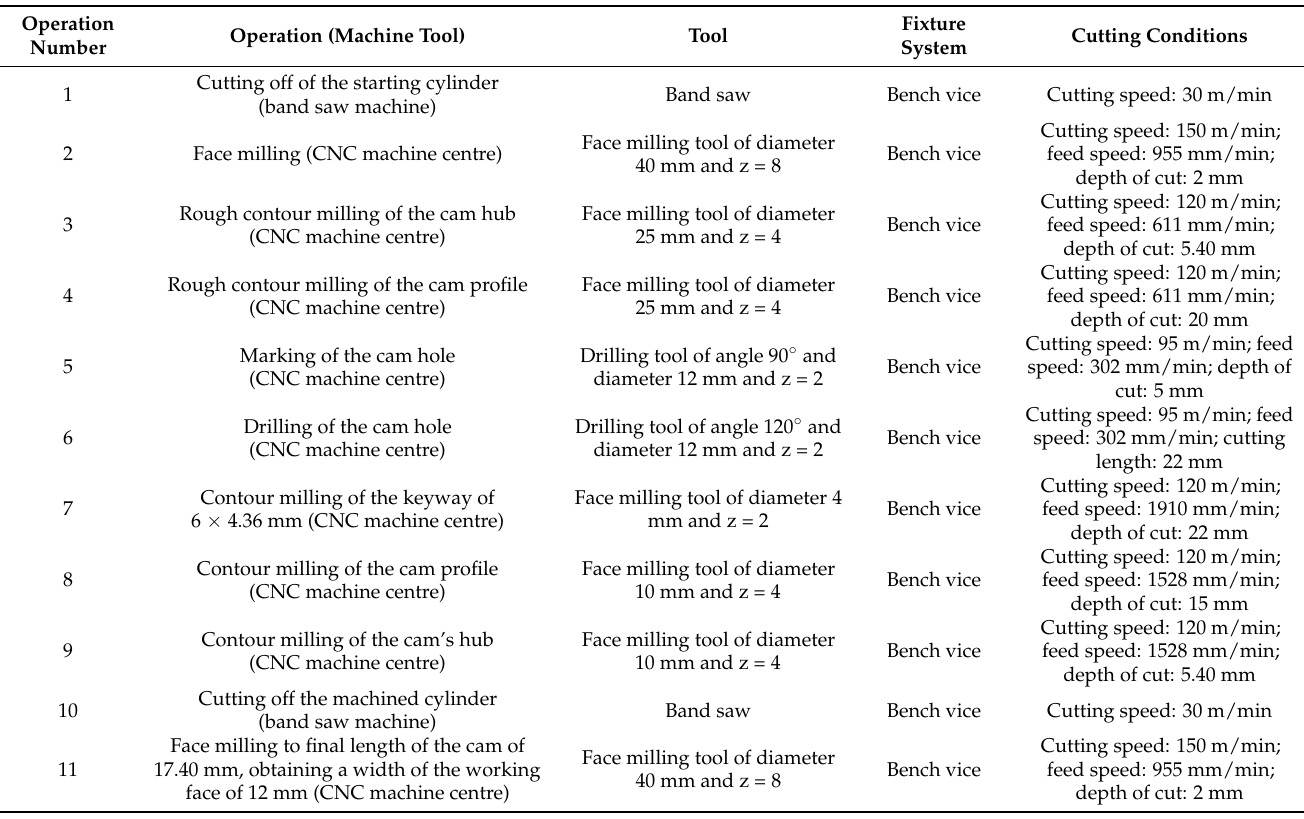
Table 3. Characteristics of the machining operations to obtain the metal cams.